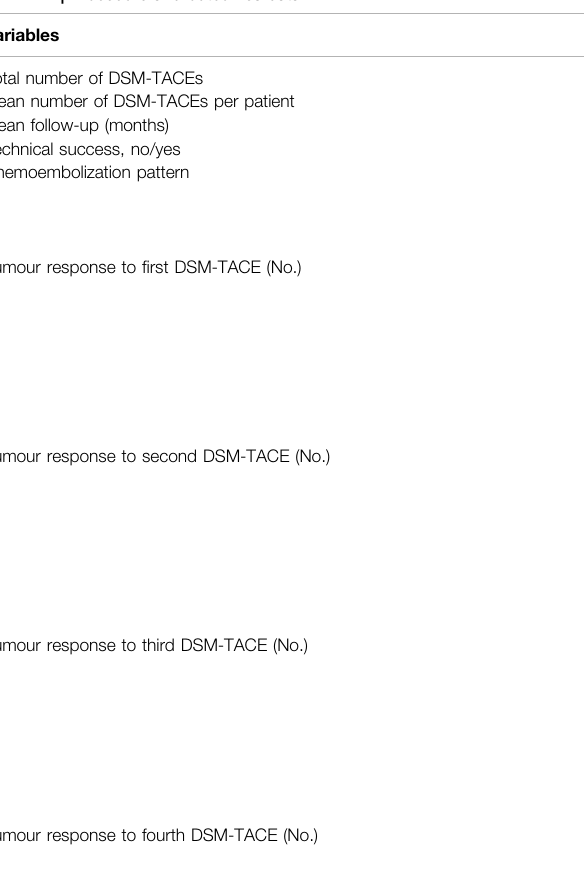
TABLE 2 | Procedure and outcomes